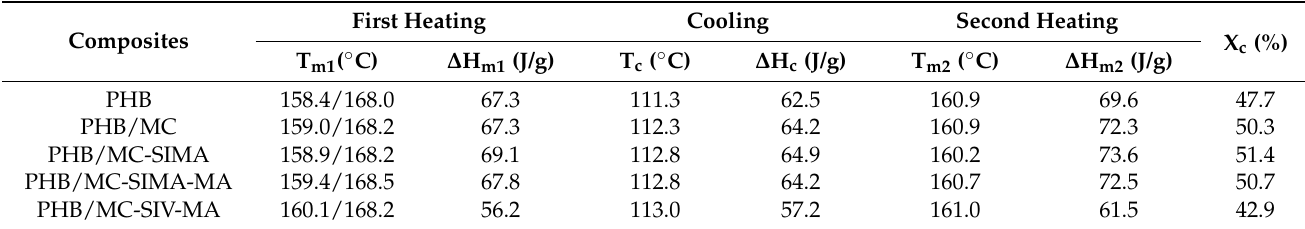
Figure 6. DSC first heating ( a ) and cooling ( b ), and second heating ( c ) of the composites. Table 3. DSC data for the composites .